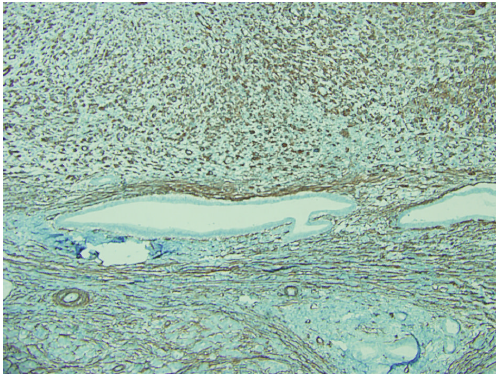
Figure 3: Smooth muscle actin immunohistochemical stain shows positive staining in the pleomorphic and spindle tumor cells, indicating smooth muscle origin of this lesion (100x).